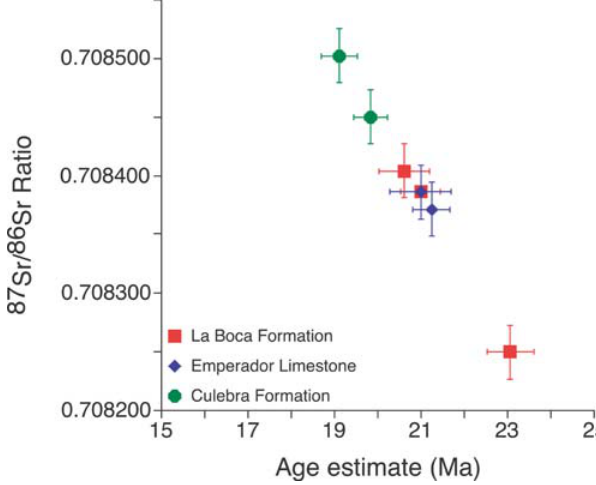
Figure 7. Scatter plot showing geologic age as a function of the 87 Sr/ 86 Sr ratio of fossil marine shells from the La Boca Formation, Emperador Limestone and upper Culebra Forma- tion. Error bars represent standard error.